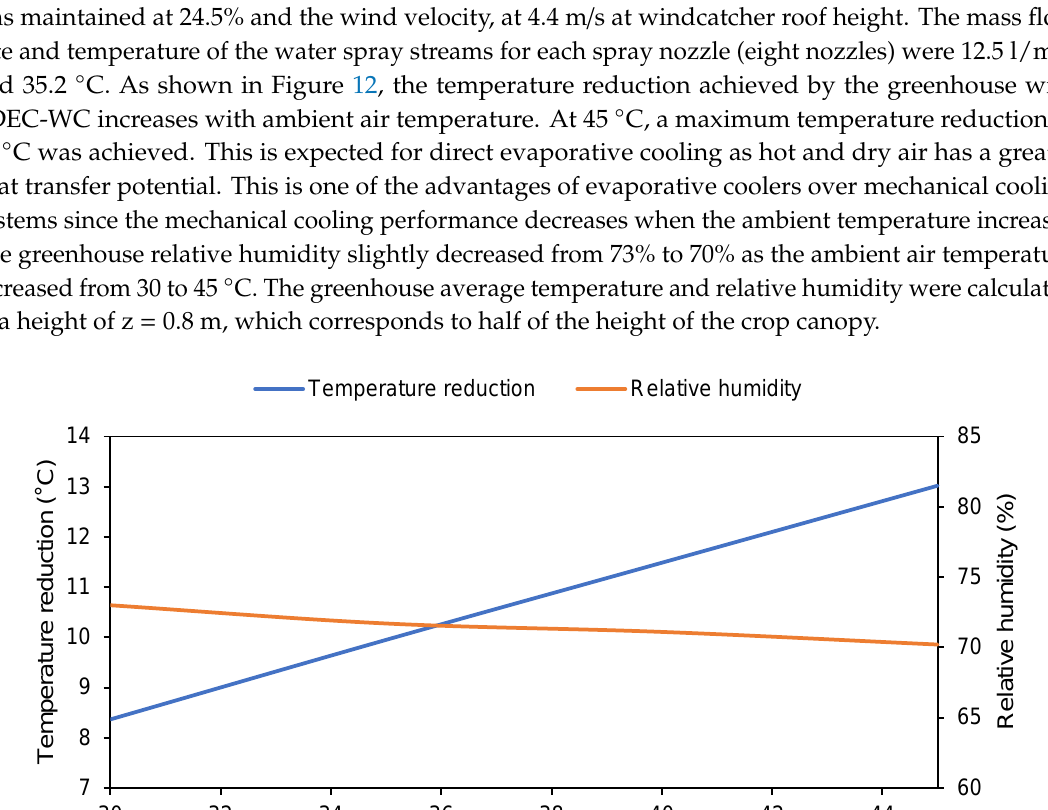
Figure 11. Air velocity along a horizontal centre line of the opening at a height of z = 0.8 m with cross- flow ventilation and with windcatchers.